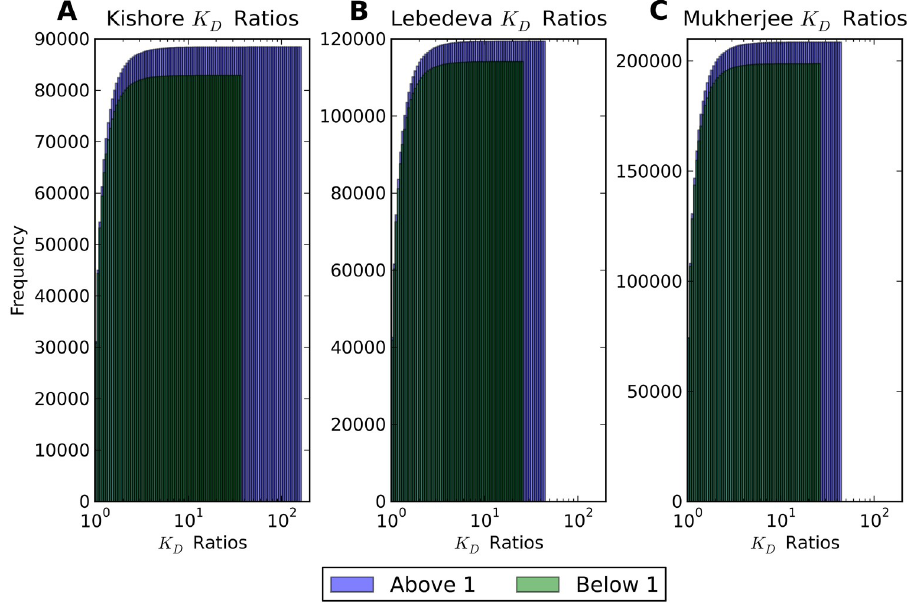
Fig 5. Cumulative histogram of K D ratios in 201 nucleotide sequences. Cumulative histograms for the affinity ratios using (A) Kishore [30] HuR binding sites, (B) Lebedeva [31] HuR binding sites, and (C) Mukherjee [32] HuR binding sites. Ratios less than 1 are reciprocated to be larger than 1, and shown in dark (green), while ratios naturally larger than 1 are shown in lighter color (blue).